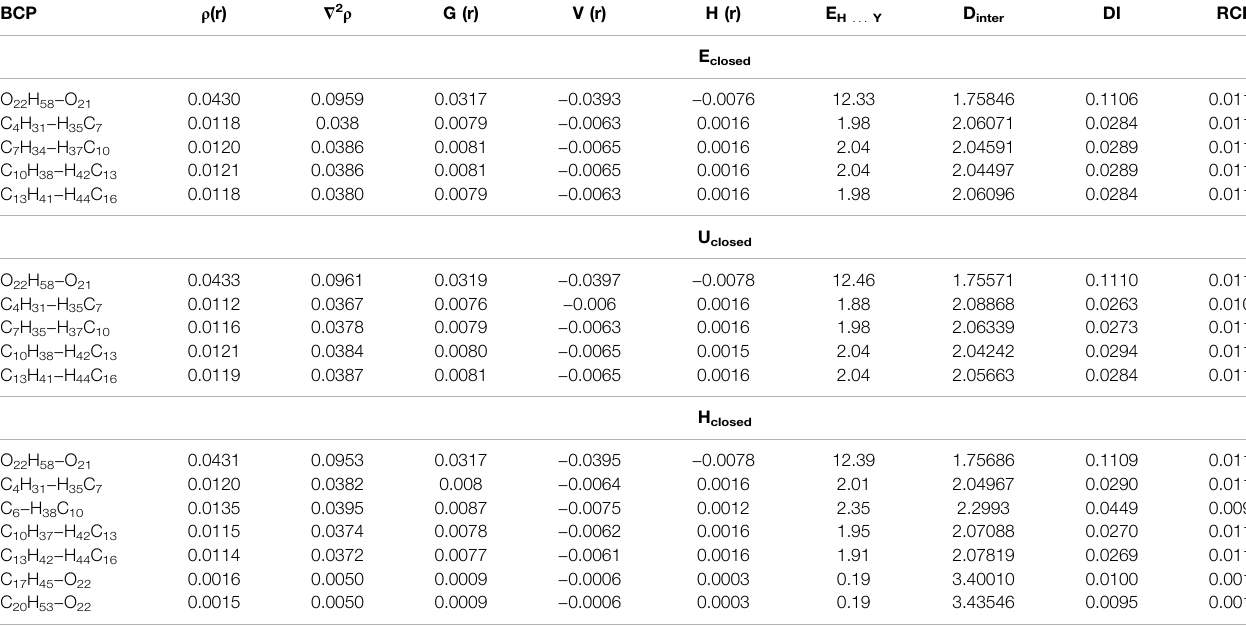
TABLE 3 | Topological parameters (a.u.), E H ... Y (kcal mol − 1 ), and interatomic distances (D inter , Å) of the conformers of anandamide: E closed , U closed , and H closed , obtained at the BP86/cc-pVTZ level of theory in chloroform.